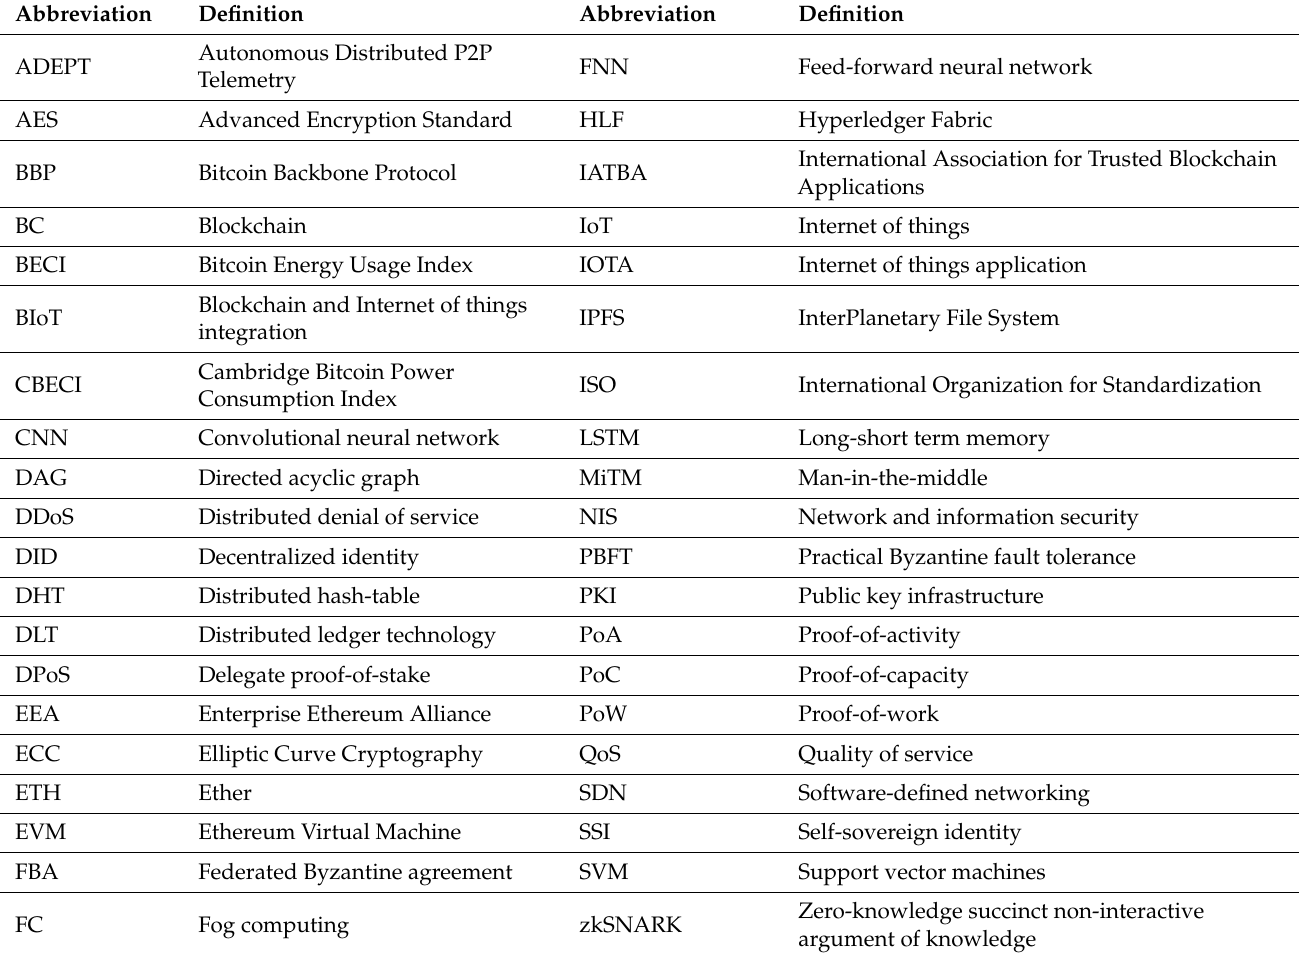
Table 1. Table of abbreviations used in the